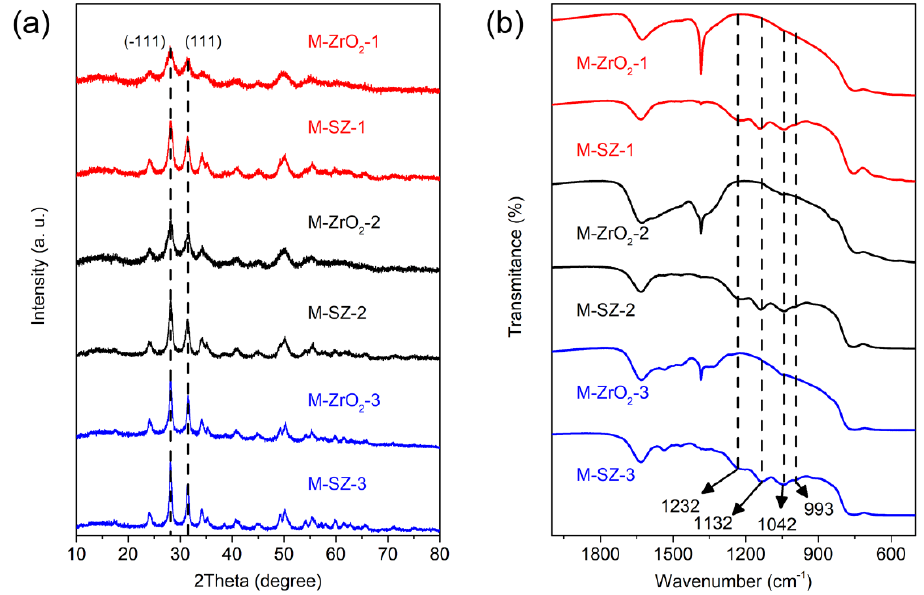
Figure 1. ( a ) The XRD patterns and ( b ) FT-IR spectra of M-ZrO 2 -1, M-SZ-1, M-ZrO 2 -2, M-SZ-2, M- ZrO 2 -3, and M-SZ-3. M-ZrO 2 -3, and